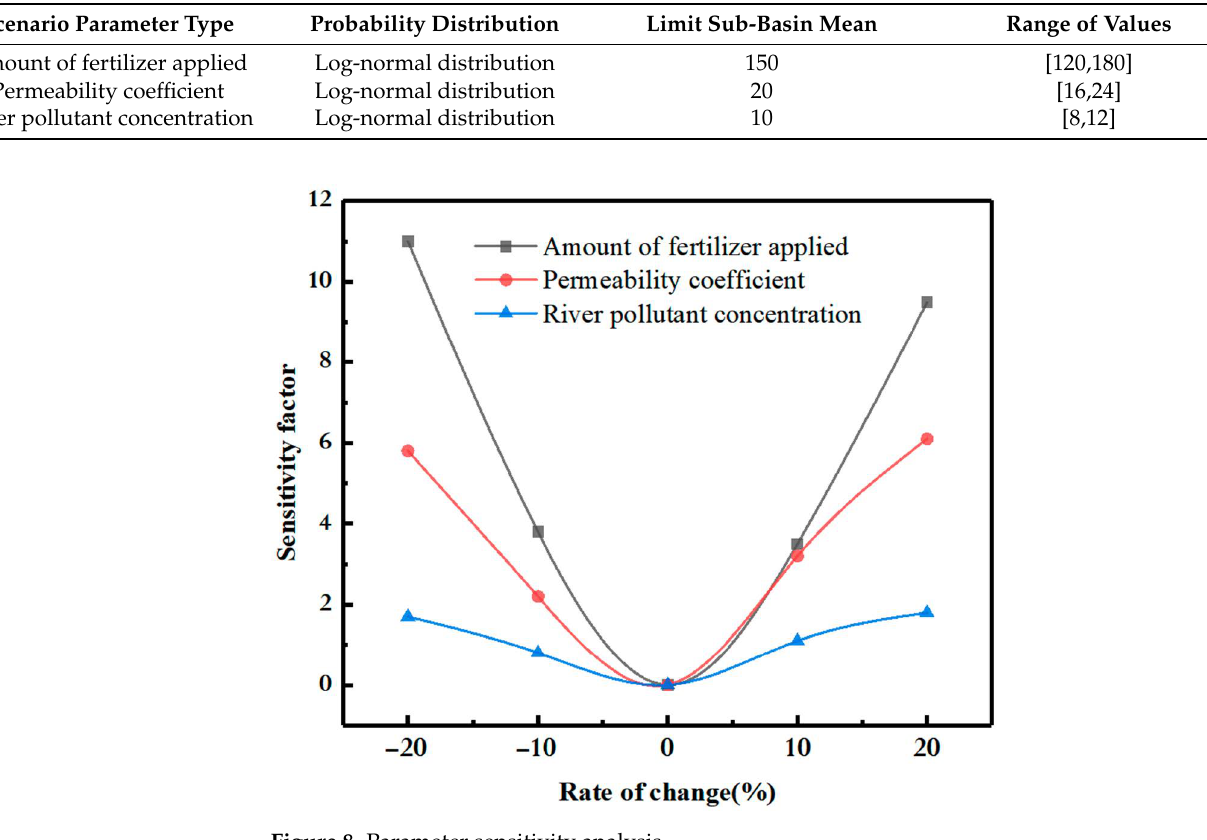
Figure 8. Parameter sensitivity analysis.